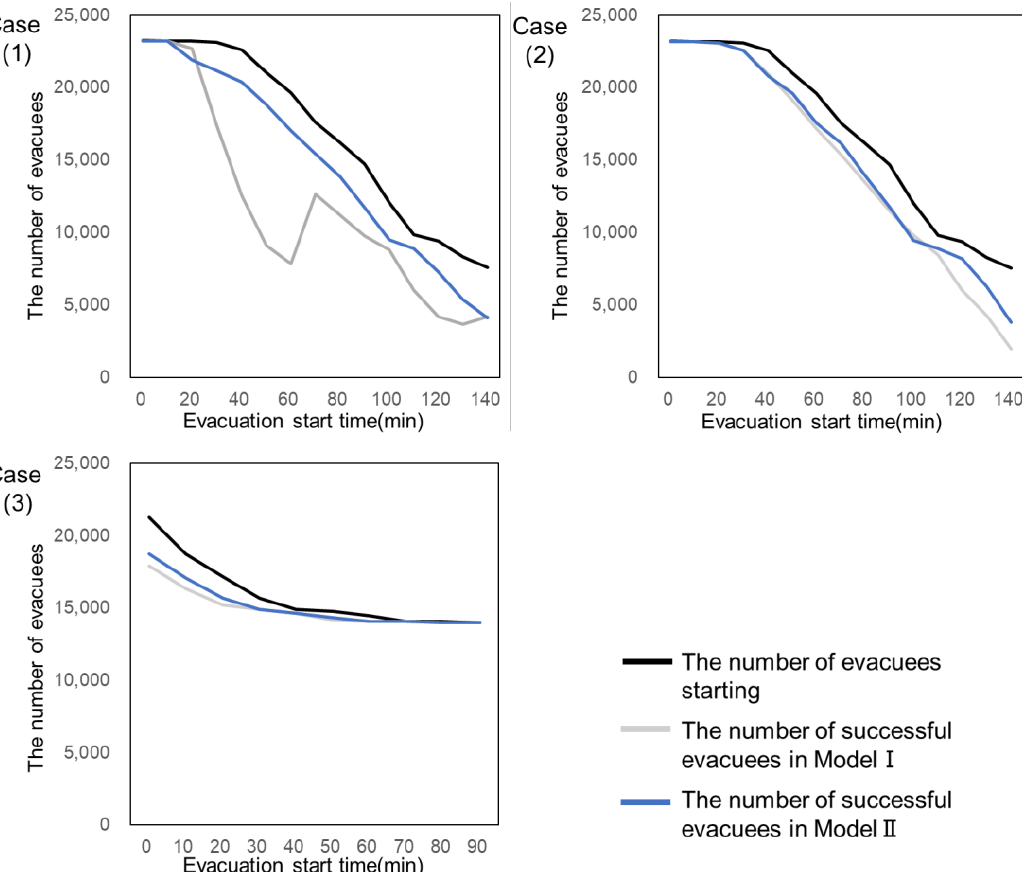
Figure 7. The number of successful evacuees at each evacuation start time. The black line indicates the number of evacuees starting from nodes (i.e., the total number of people minus the number of people assigned to nodes already in the flooded area); the gray line indicates the number of successful evacuees for Model I, and the blue line indicates those for Model II.